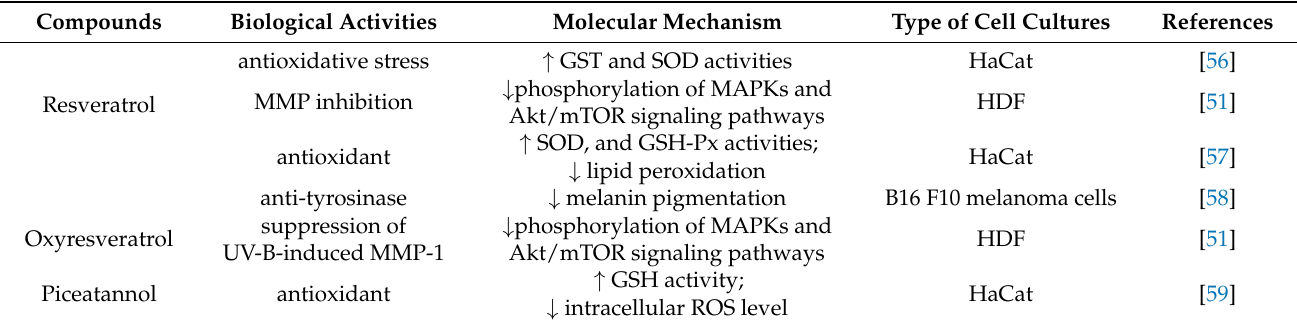
Table 2. Studies of molecular targets of stilbenoids in skin